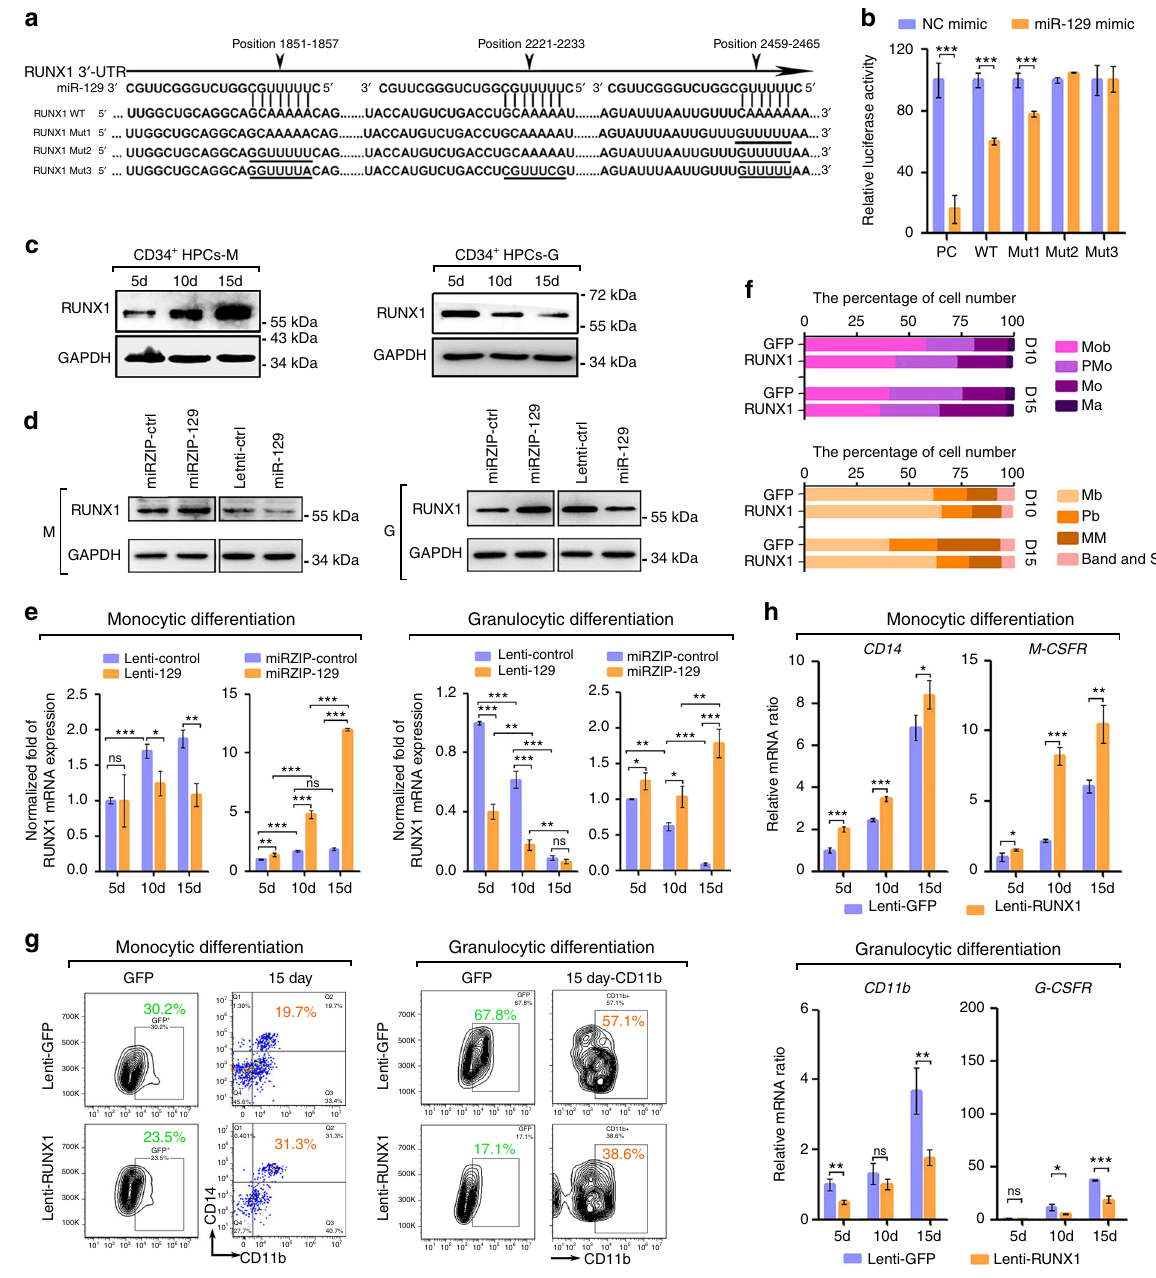
Fig. 9 miR-129 targets RUNX1 to modulate myeloid differentiation. a A computational prediction of the conserved binding sites and the designed mutated sequences in these sites within the 3 ′ UTR of the human RUNX1 mRNA. b Relative luciferase activity of the indicated reporter constructs. PC, positive control. Three technical replicates from a single experiment representative of two independent experiments. c Immunoblot of the endogenous RUNX1 levels in CD34 + HPCs undergoing monocytic or granulocytic differentiation. d Immunoblot of RUNX1 expression in CD34 + HPCs transduced with lenti-129, miRZip-129 or their controls on day 10 of monocytic or granulocytic differentiation. e qPCR of the RUNX1 mRNA levels in CD34 + HPCs transduced with lenti- 129, miRZip-129 or their controls during monocytic and granulocytic differentiation. Three technical replicates from a single experiment. f , g CD34 + HPCs were transduced with lenti-RUNX1 or lenti-GFP control for 24 h and then cultured for 15 days to allow the cells to differentiate into monocytes or granulocytes. Quantitation of the Giemsa staining was shown in f and FACS analysis of the CD14 + /CD11b + and CD11b + populations of GFP-positive cells on day 15 ( g ). h qPCR analysis of the monocyte-granulocyte markers at the indicated times during monocytic or granulocytic differentiation of RUNX1- overexpressing cells. Three technical replicates from a single experiment. Data are shown as means ± s.d. * P < 0.05, ** P < 0.01, *** P < 0.001, Student ’ s t